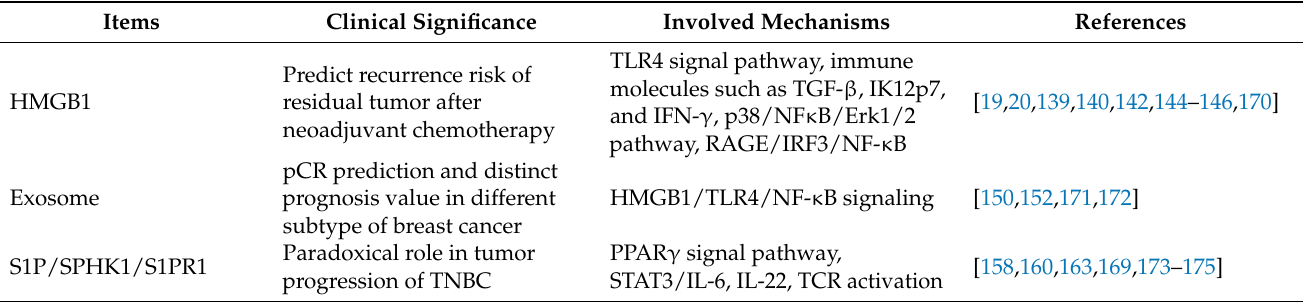
Table 3. Clinical significance and involved mechanisms of DAMPs-associated